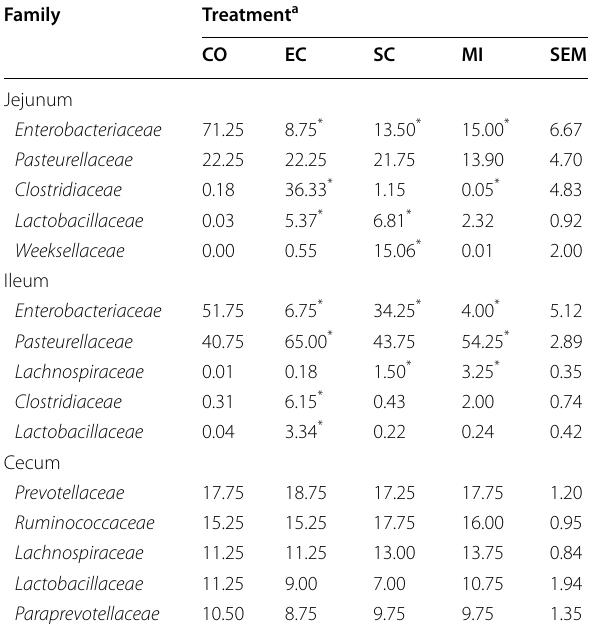
Table 6 Relative abundance of intestinal microbiota with administration of EC12, SCE, and mixture of EC12 and SCE in weaning pigs without ETEC